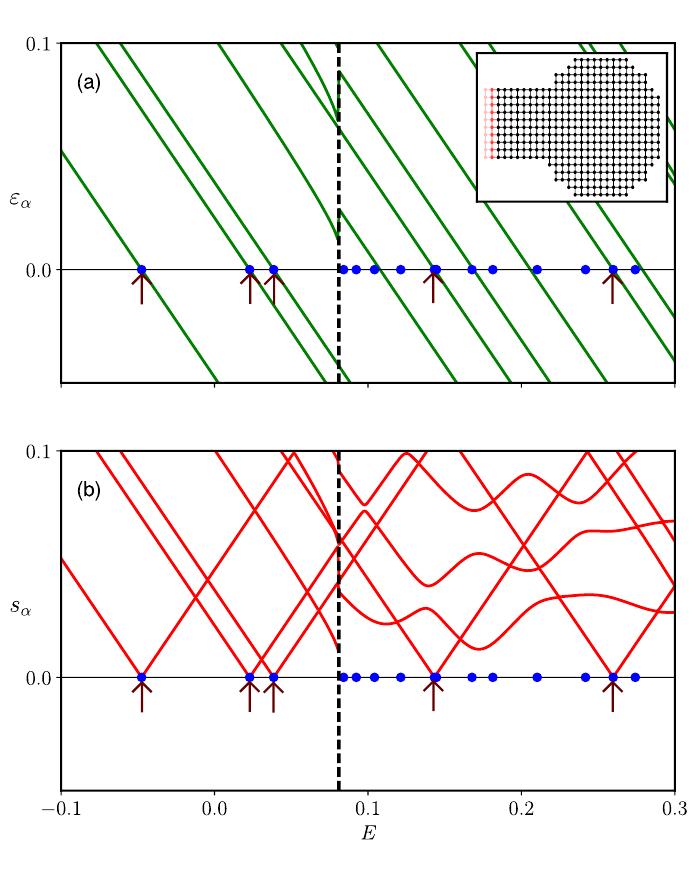
Figure 2: (a): eigenvalues (cid:34) α ( E ) of Eq. (17) as a function of E for a quantum billiard. (b): lowest singular values s α ( E ) of the left-hand side of Eq. (11) for the same billiard. Inset: = − 0.1. The blue dots correspond schematic of the billiard, described by Eq. (23) with v g